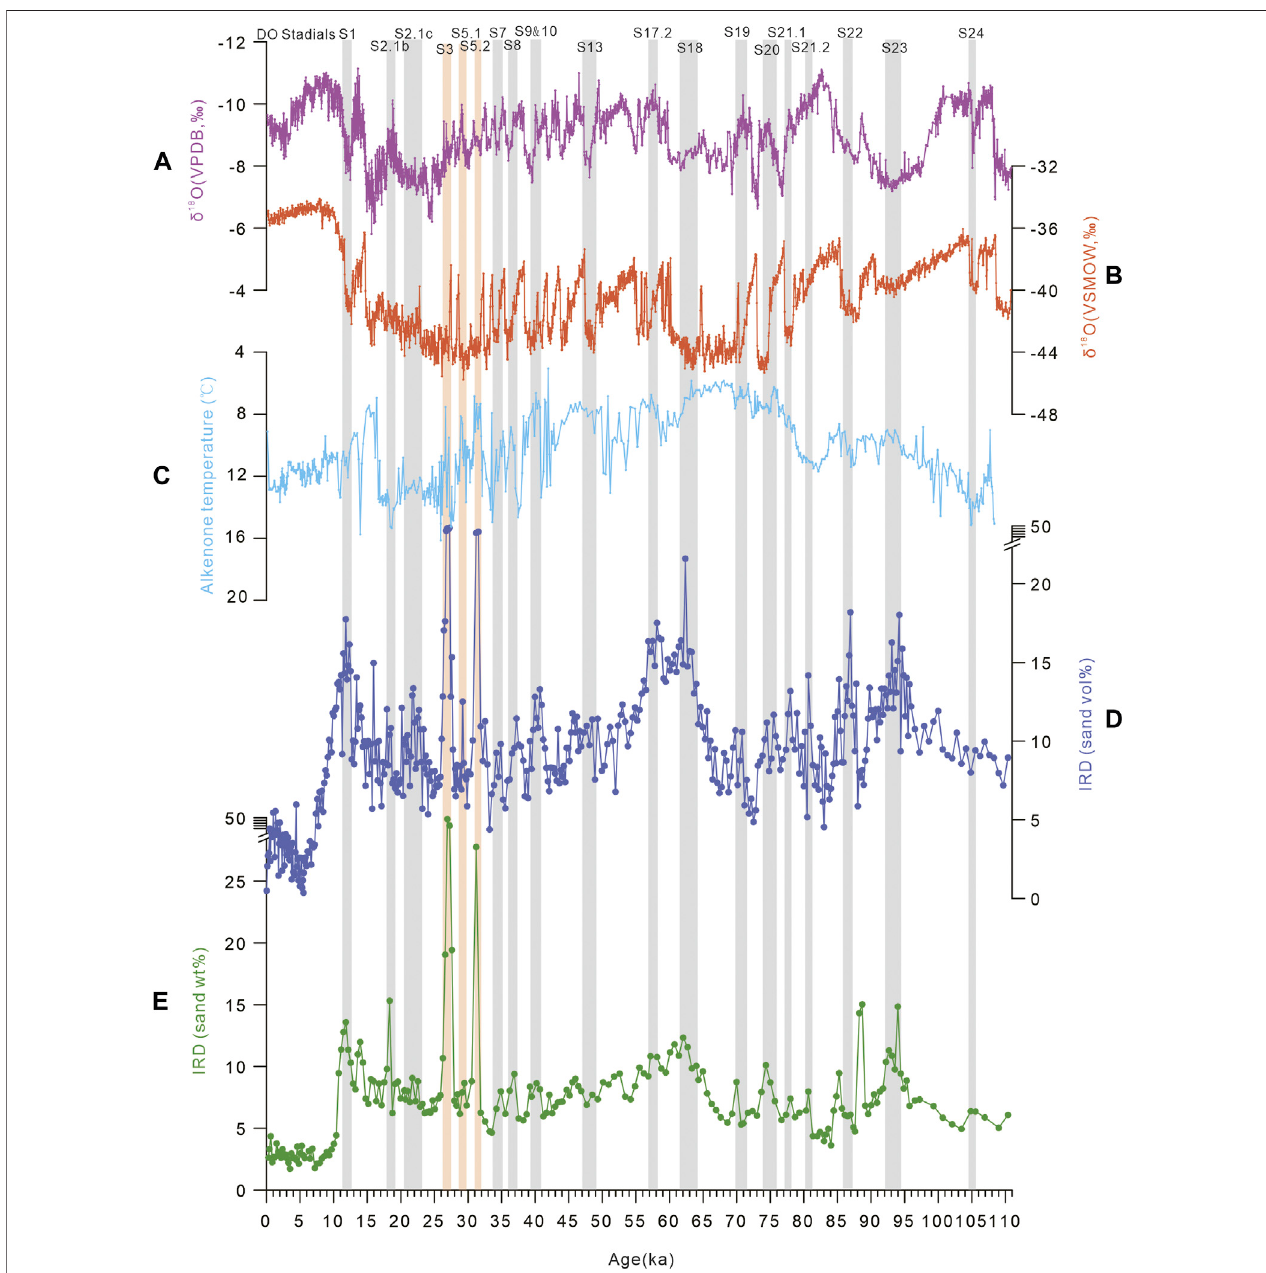
FIGURE5| Comparisonbetweenmillennial-scalechangesinIRDproxiesincoreLV55-40-1andotherproxies. (A) Oxygenisotopesfromstalagmites(Chengetal., 2016), a proxy for the East Asian summer monsoon (EASM), (B) Oxygen isotopes of the NGRIP ice core (Andersen et al., 2004), a proxy for air temperature, (C) Alkenone-derived temperature ( ° C) (Harada et al., 2008), indicating AO variations, (D) IRD (vol%) and (E) IRD (wt%) in core LV55-40-1. Grey shadows represent DOSs intervals, orange shadows represent intervals potentially affected by volcanic eruptions.